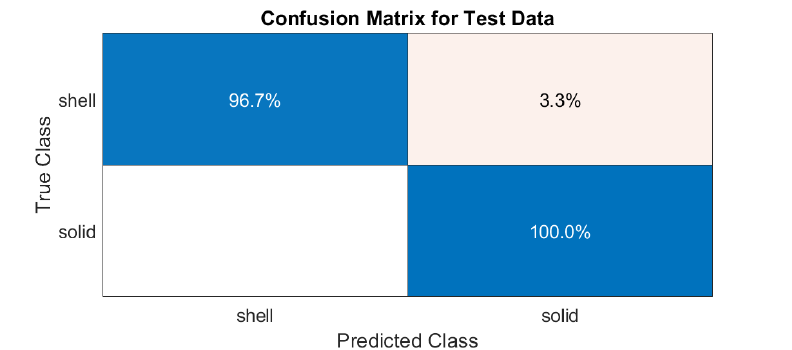
Figure 5. Confusion matrix for the CNN trained to classify geometry (shell or solid) with the highest classification accuracy (Table 9). The network was trained using the scalogram representation with a 20 dB SNR, resulting in a 97.91% average overall accuracy. This network consisted of one convolutional layer with four feature maps per layer (Table 4). The blue boxes indicate correct classification while the orange boxes indicate incorrect